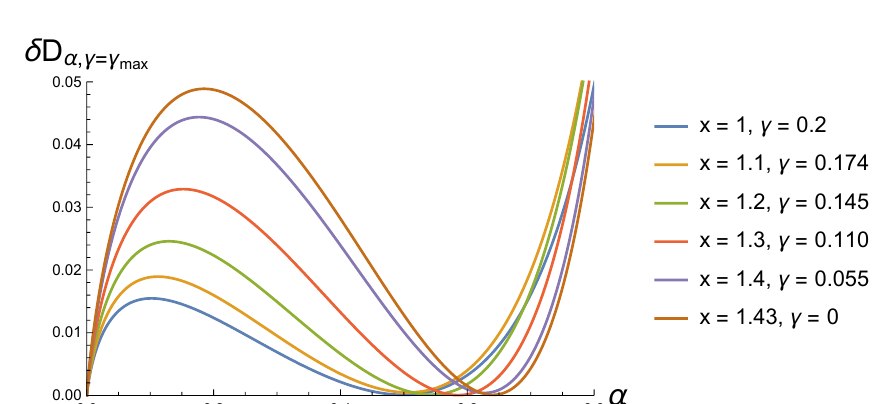
) (cid:0) D (cid:11) ( (cid:26) 2 k (cid:26) ) for (cid:1) 1 = 0 : 9 and (cid:1) 2 = 0 : 6 with varying R R